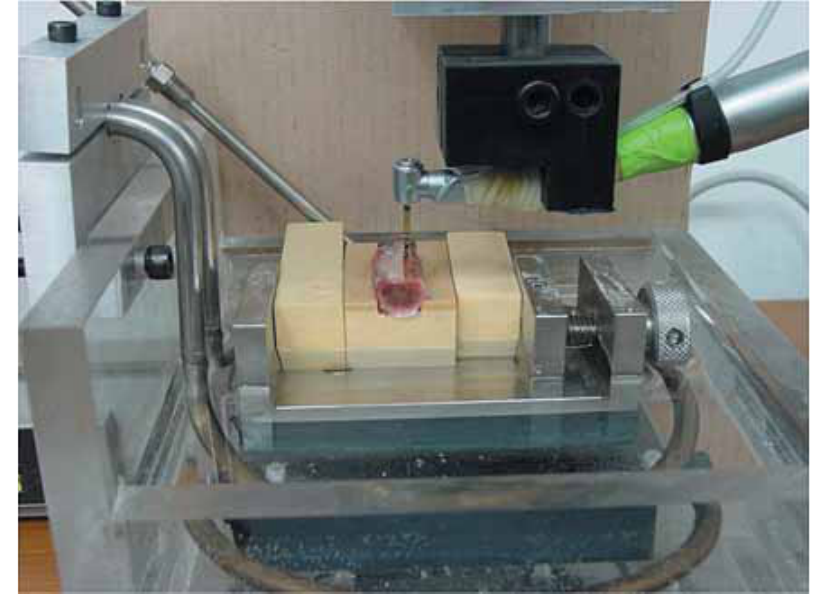
Figure 1- Pig rib immobilized to resin